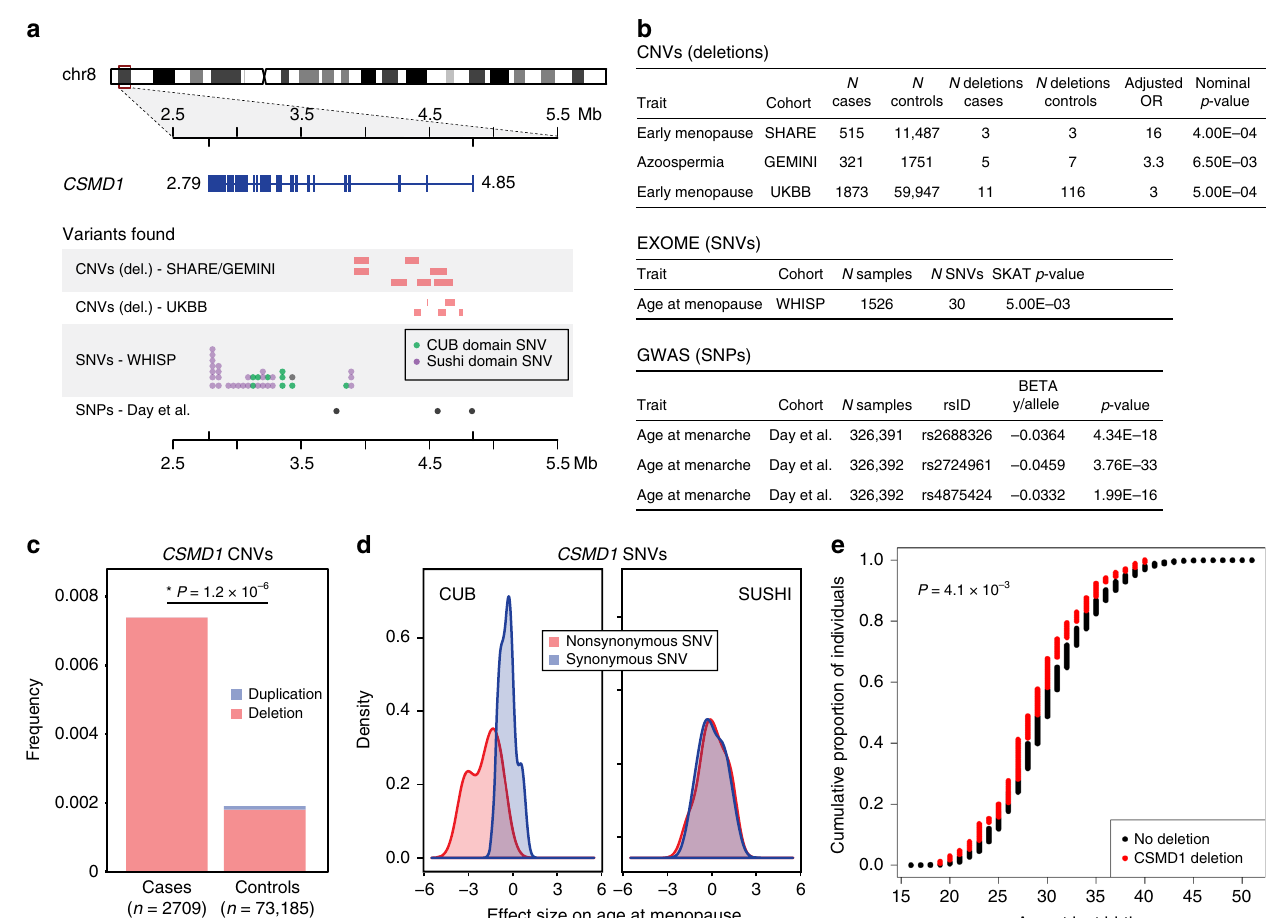
Fig. 1 Genetic variants in CSMD1 are associated with primary gonadal dysfunction. a The landscape of genetic variation across CSMD1 among all cohorts. SHARE/GEMINI: rare deletions overlapping CSMD1 among 14,074 females and males from the SHARE and GEMINI cohorts; UKBB: rare intron 1 – 3 deletions observed in 63,064 females from the UK Biobank early idiopathic menopause cohort — for clarity of visualization only the deletions observed in cases are shown; WHISP: 37 rare SNVs overlapping CSMD1 among 1,526 exome-sequenced females; and Day et al.: three statistically independent lead SNPs from a large-scale GWAS of age at menarche in females are depicted as points along the bottom of the fi gure (left to right): rs2688326, rs2724961, and rs4875424 28 . All coordinates are in hg19. b Summary of the human genetic evidence that CSMD1 variants are associated with gonadal function in men and women described in this study. c Stacked barplot depicting frequency of rare CNVs overlapping introns 1 – 3 of CSMD1 among 2,709 cases of male or female gonadal dysfunction versus 73,185 controls. Rare deletions over CSMD1 segregate signi fi cantly with cases (odds ratio = 3.6; meta-analysis